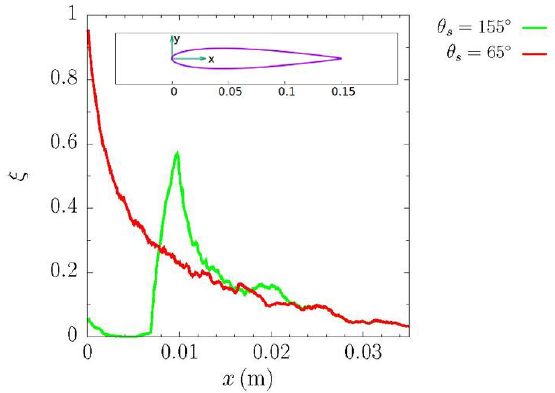
Figure 7. Resulting collection efficiency, taking into account super-hydrophobic surface rebound.